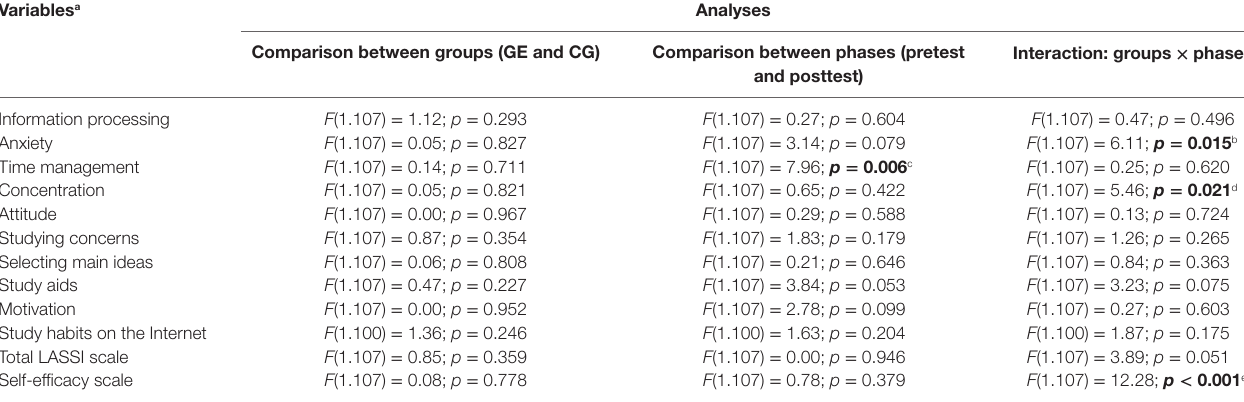
TaBle 4 | ANOVA results for comparison of scores between the participating groups (EG) and the non-participating groups (CG) on course. Variables a analyses comparison between groups (ge and cg) comparison between phases (pretest interaction: groups × and posttest)